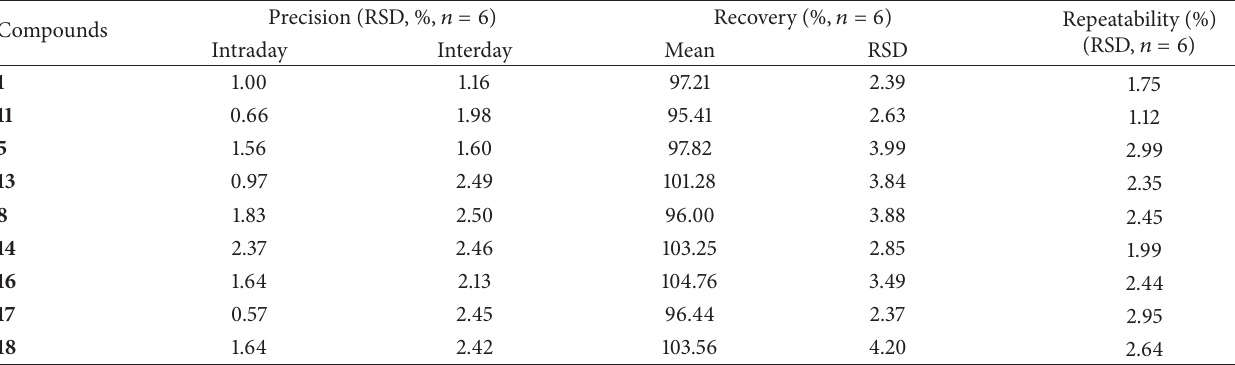
Table 4: Precision, recovery, and repeatability of nine